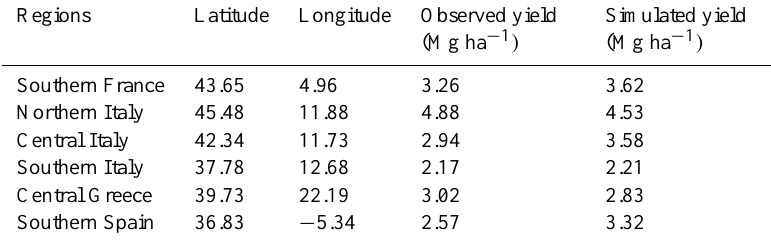
Simulated yield (Mg ha − 1 )